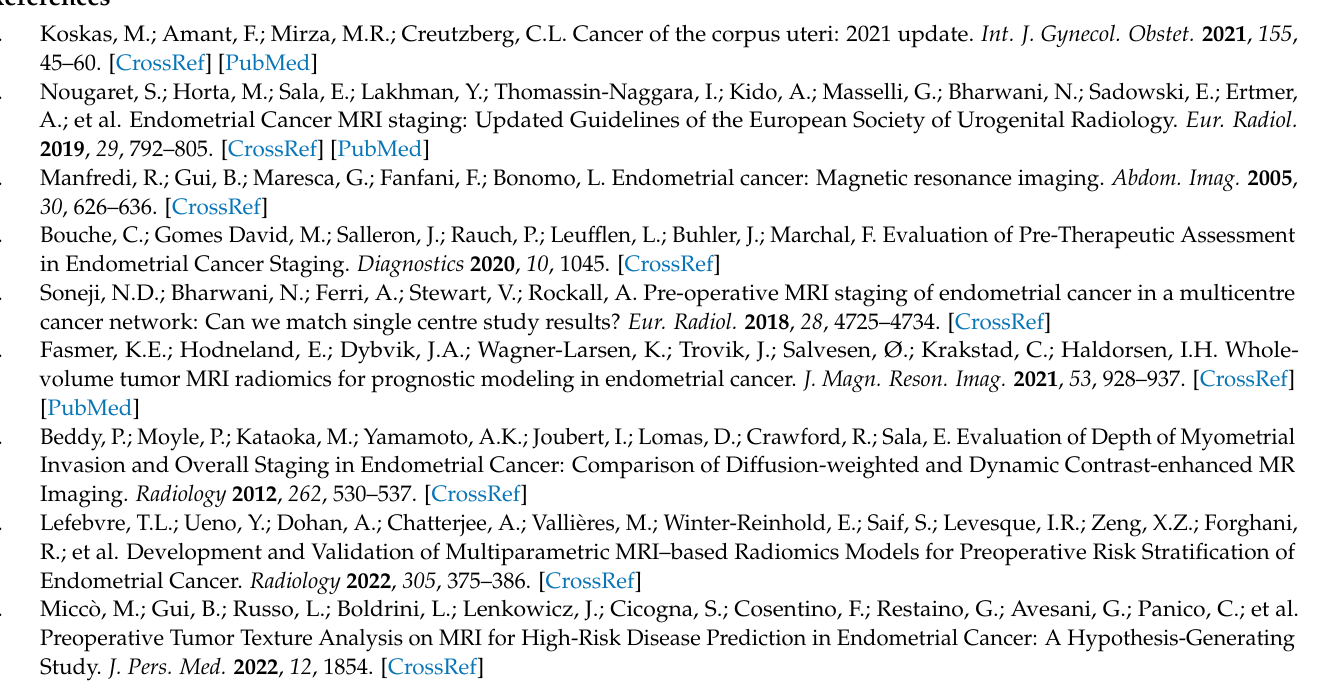
DMI prediction; Figure S2: Feature importance bar plot for cancer risk prediction; Figure S3: Feature importance bar plot for histological type prediction, Figure S4: Histological type prediction results including grade as a predictor; Figure S5: Feature importance bar plot for LVSI